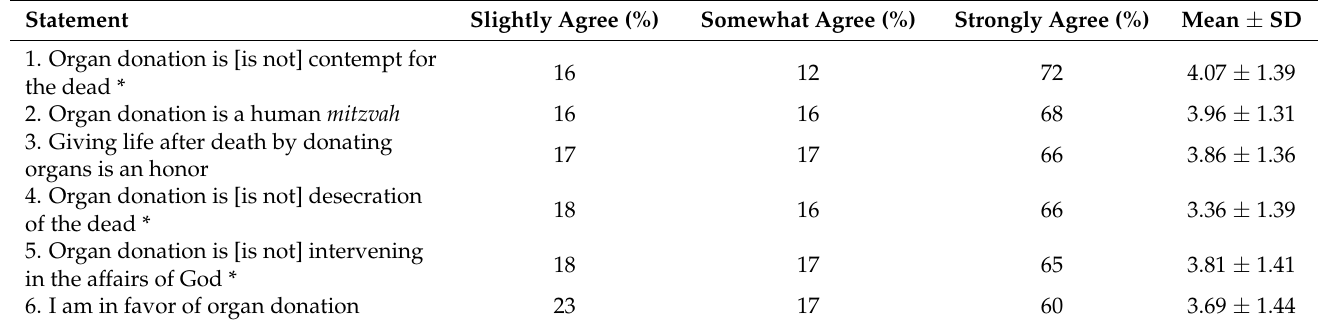
Table A2. Distribution of responses to the questionnaire regarding attitudes to organ